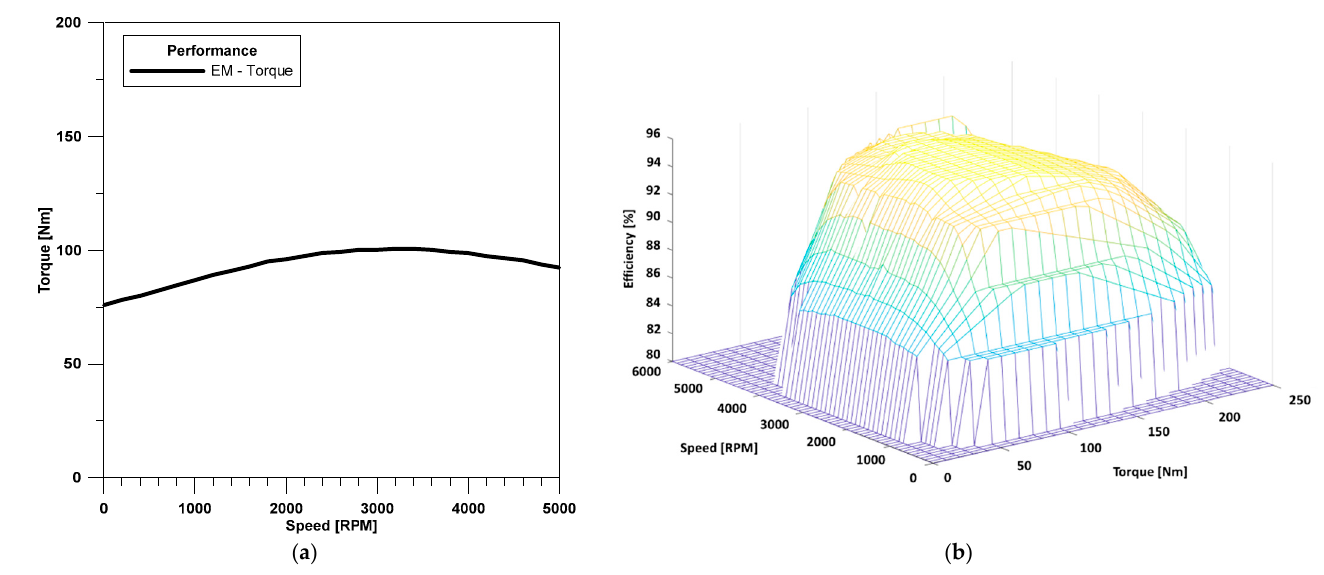
Figure 5. Manufacturer’s data. ( a ) EM maximum torque; ( b ) efficiency map.